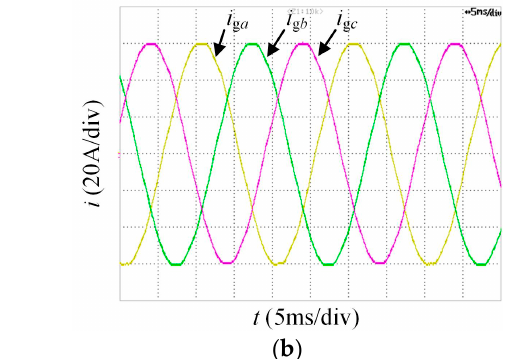
Figure 16. Transient response of the proposed grid-connected inverter. 6. Conclusions A modified method is proposed in this paper to design an H ∞ repetitive controller by considering the adoption of capacitor-current-feedback active damping and the delay of digital implementation. Compared with the traditional design method, the active damping is included in the H ∞ repetitive controller design process by introducing an equivalent controlled plant which is built based on the model of the LCL-filter and the feedback of capacitor-current. Furthermore, the